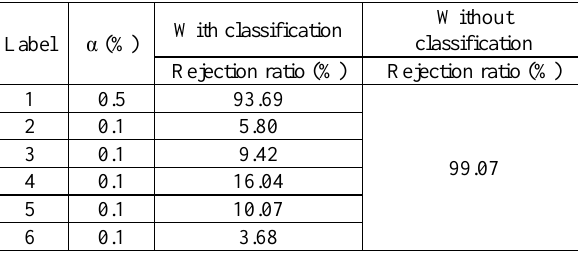
Table 7. The rejection ratio with and without